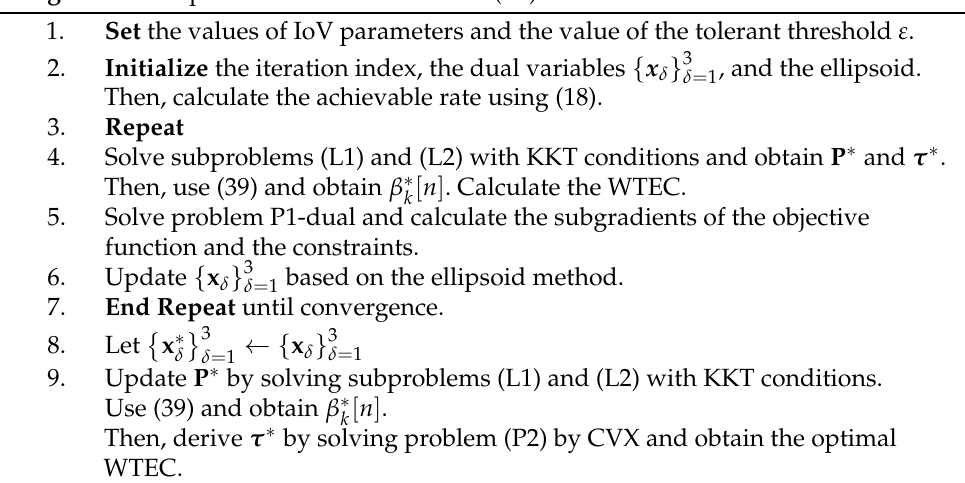
Algorithm 1: Optimal Solution to Problem